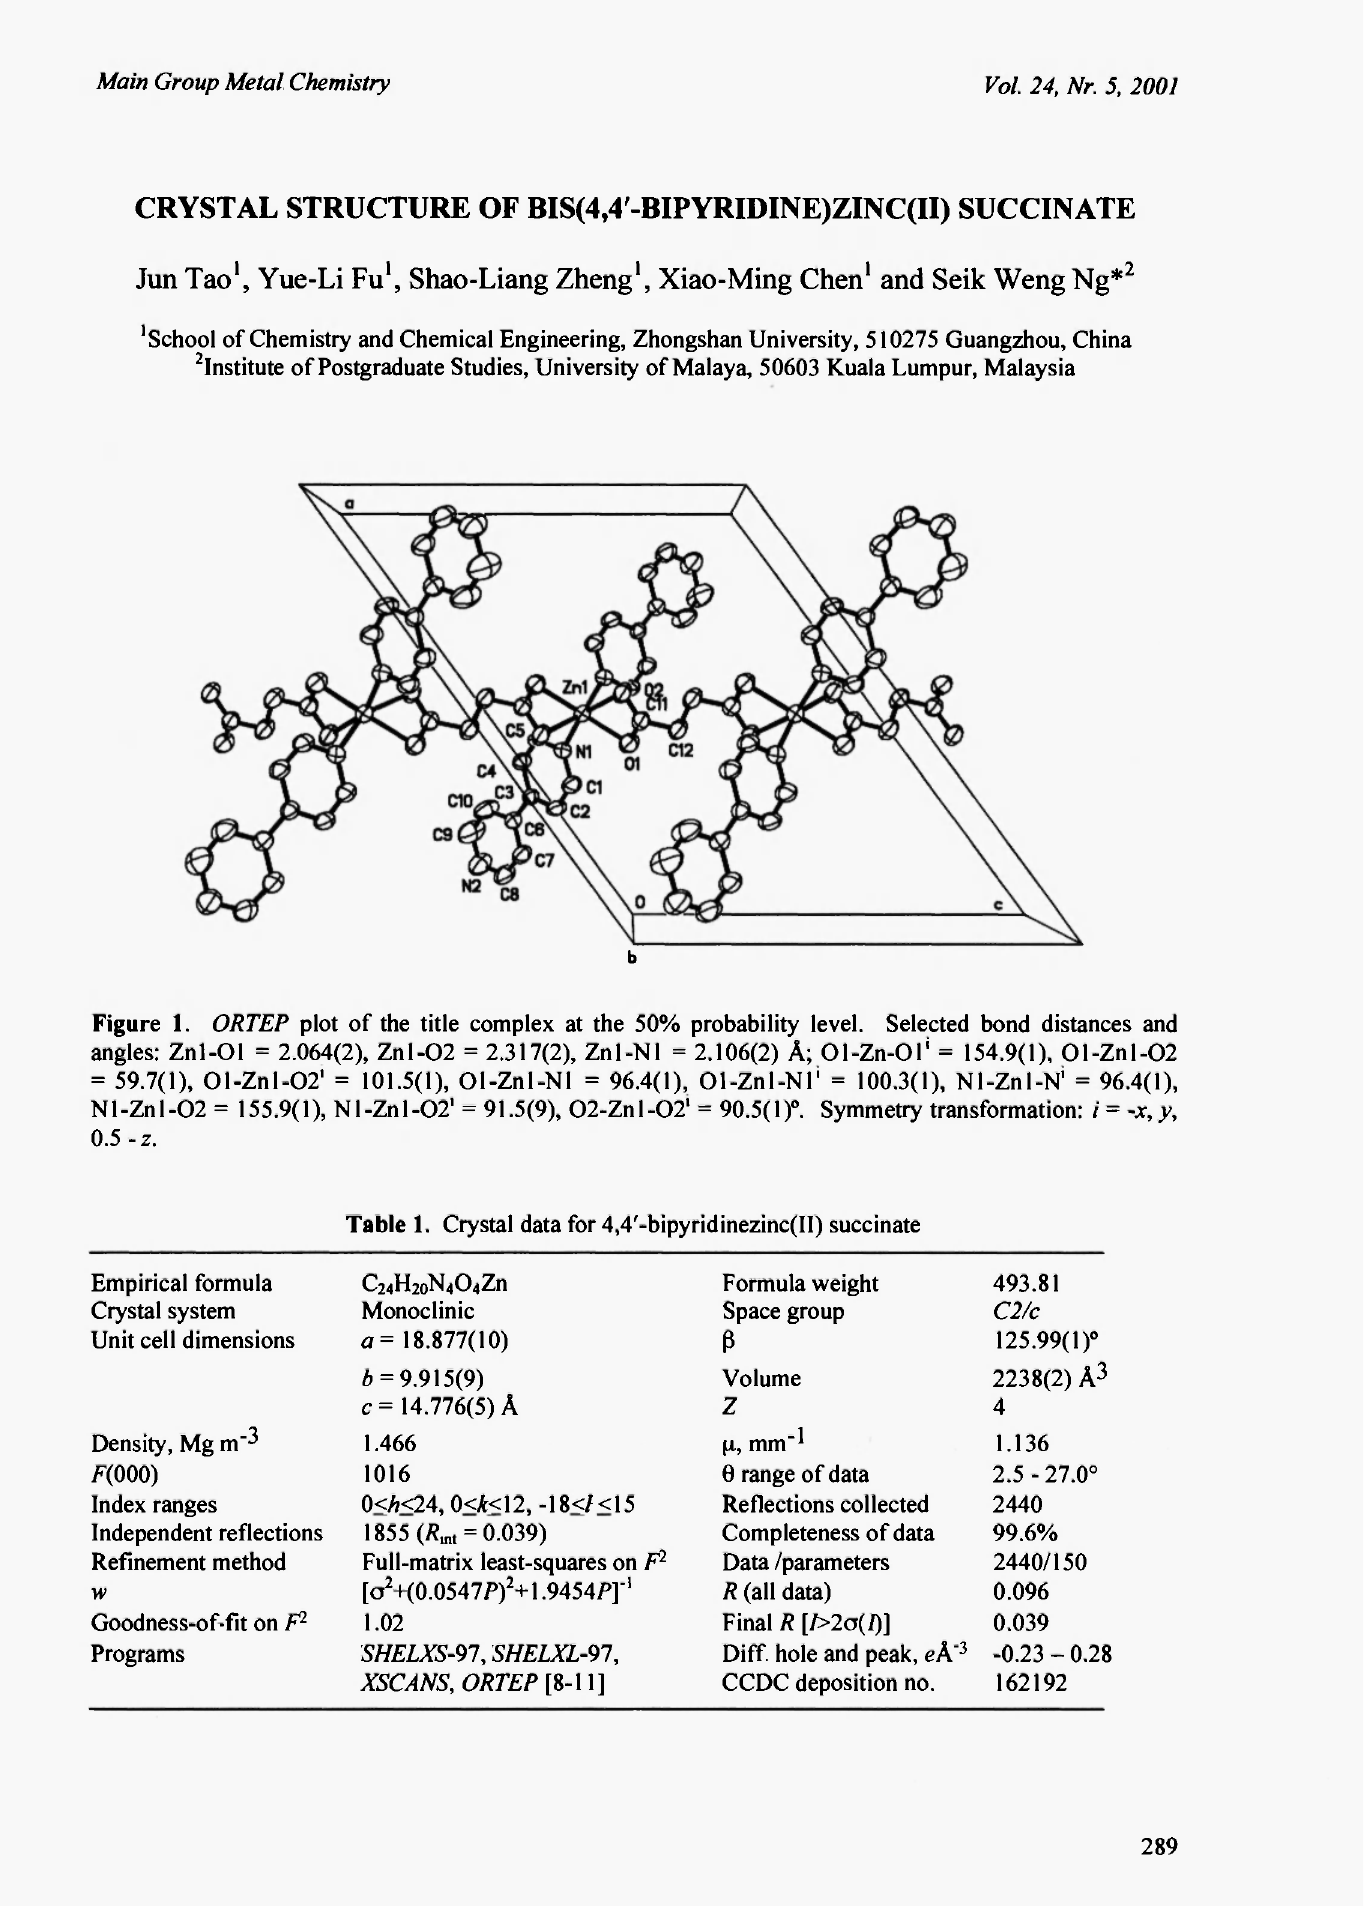
Table 1. Crystal data for 4,4'-bipyridinezinc(II)